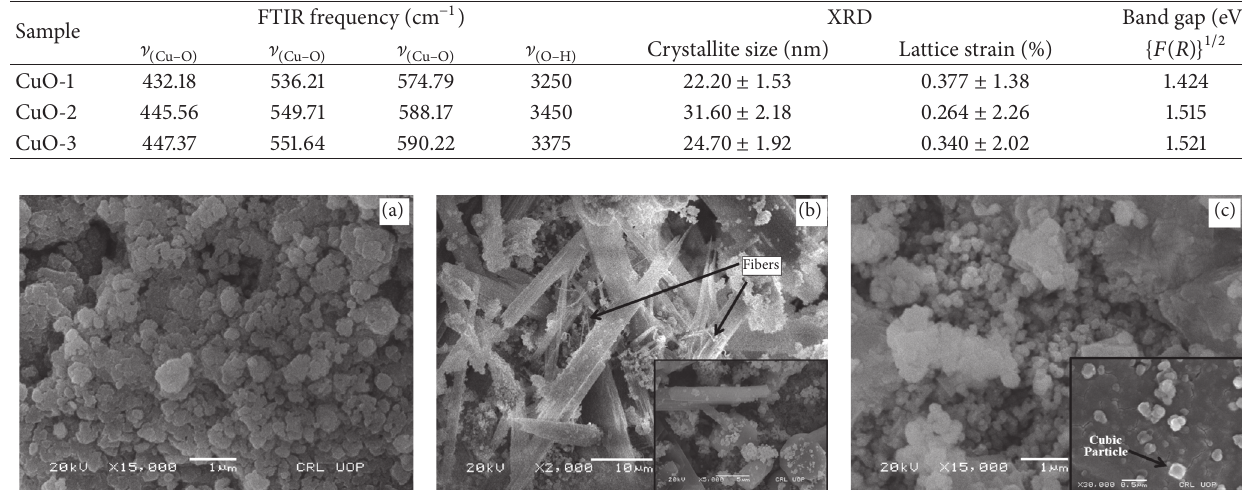
(inset in Figure 2(c)). The average size of the self-assembled cubic structures is measured to 0.26 𝜇